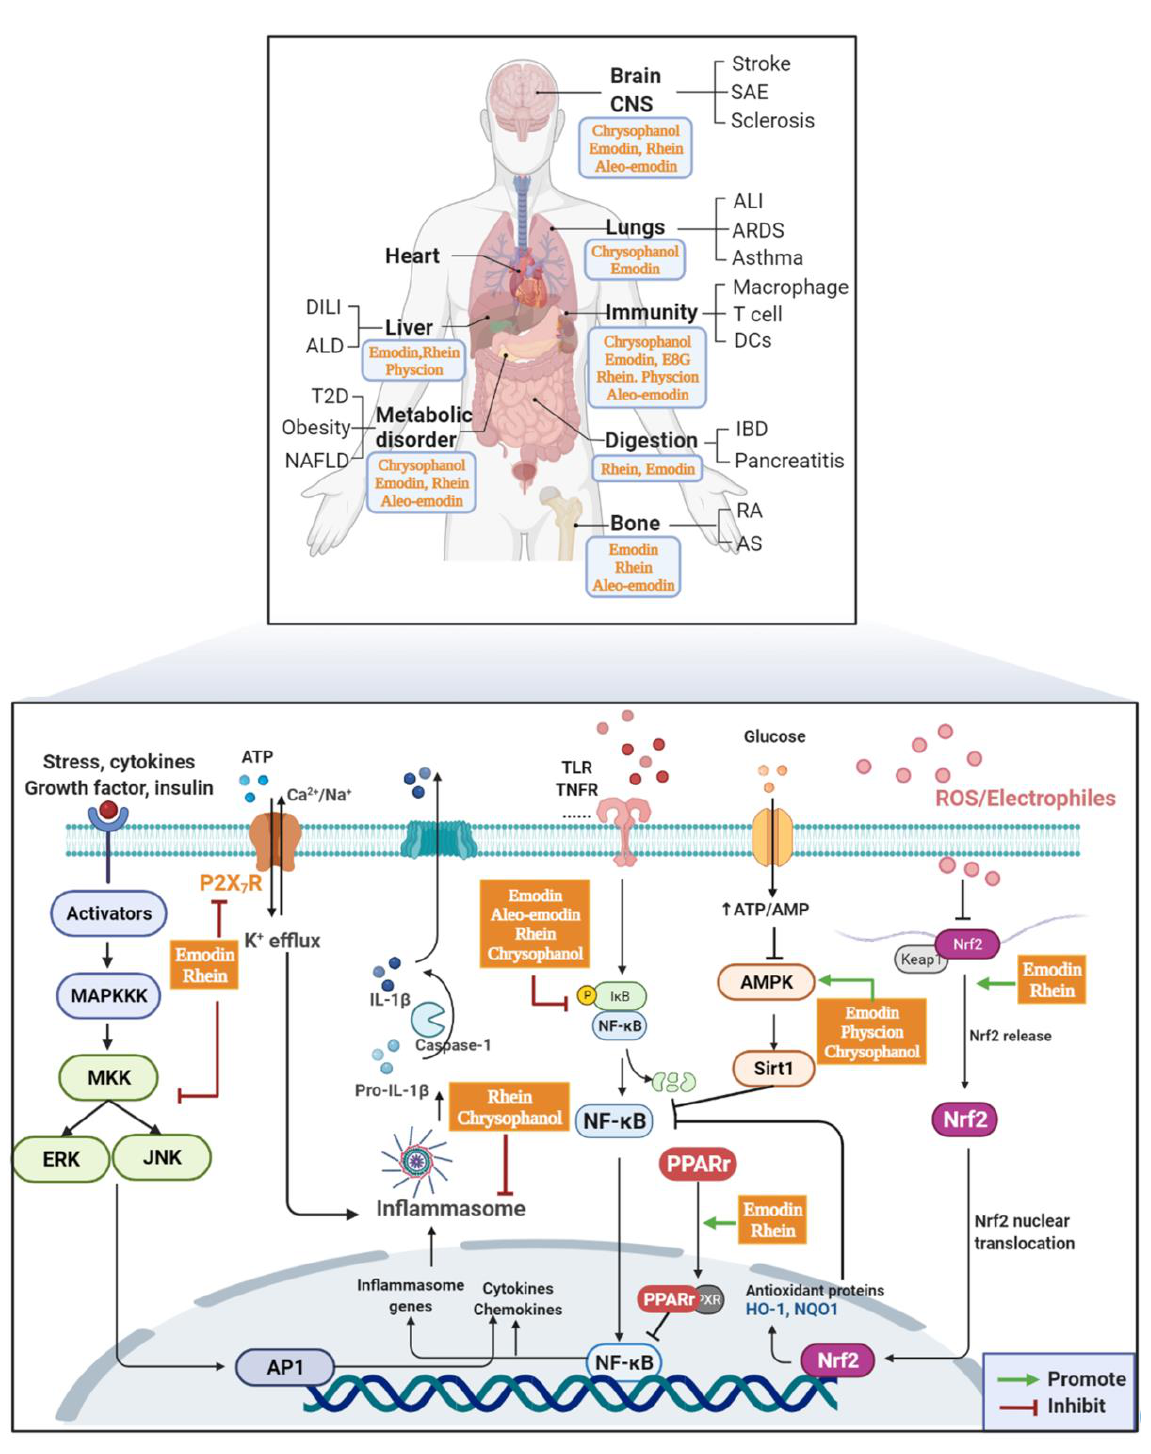
Figure 2. Effects and mechanism of AQs on inflammatory diseases/injury.